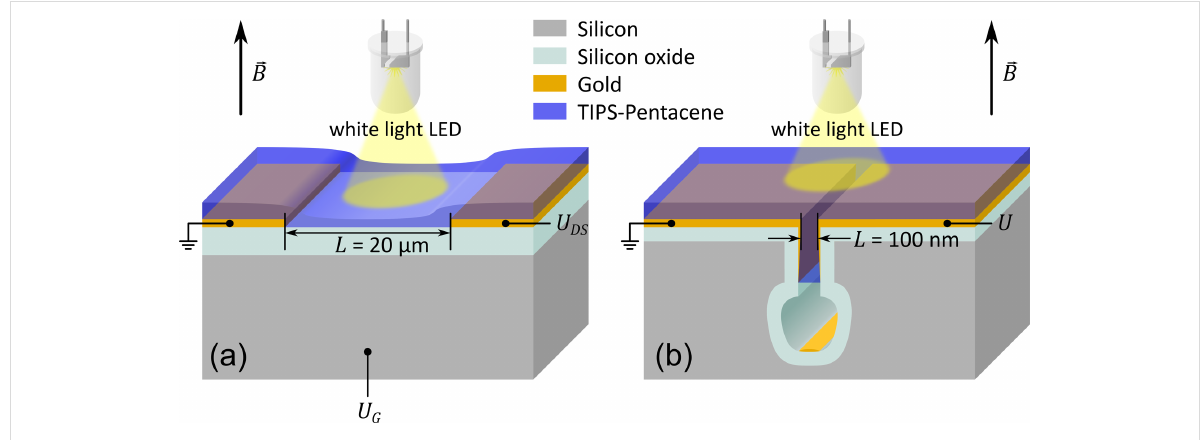
Figure 1: Schematic diagram of the experimental setup: (a) Commercial bottom-contact OFET substrates; (b) planar device structure with trench-iso- lated electrodes (HED-TIE).